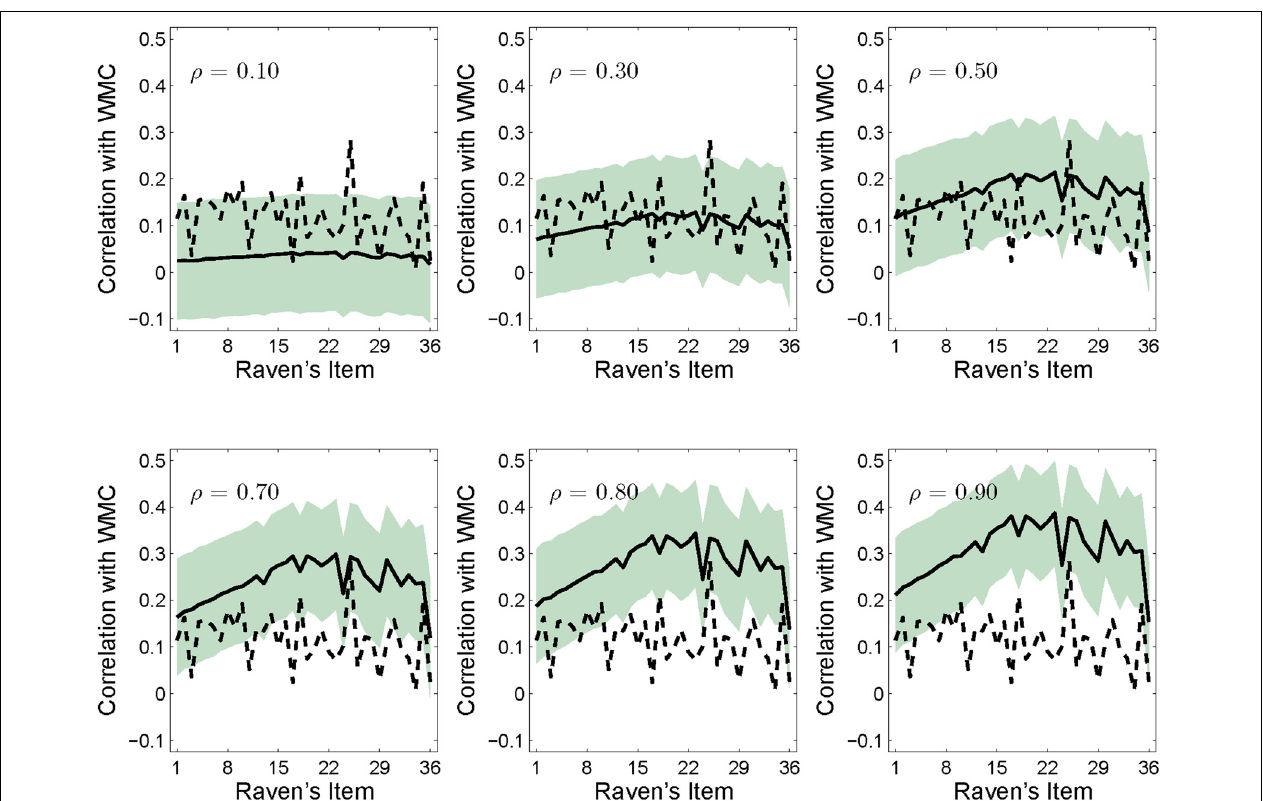
FIGURE 4 | Simulation results for point bi-serial correlations between WMC and the Raven’s items for population correlations of 0.10, 0.30, 0.50, 0.70, 0.80, and 0.90, respectively. Simulations involved 10,000 replications each, and the shaded areas represent